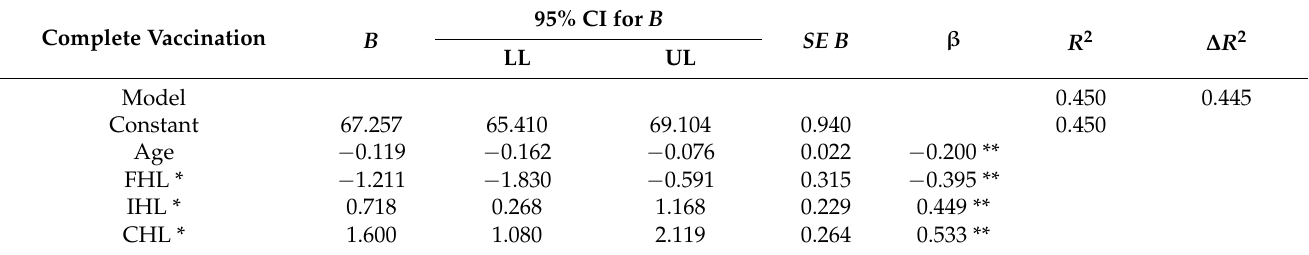
Table 3. Multiple Regression Results for Complete Vaccination Prevalence Controlling for